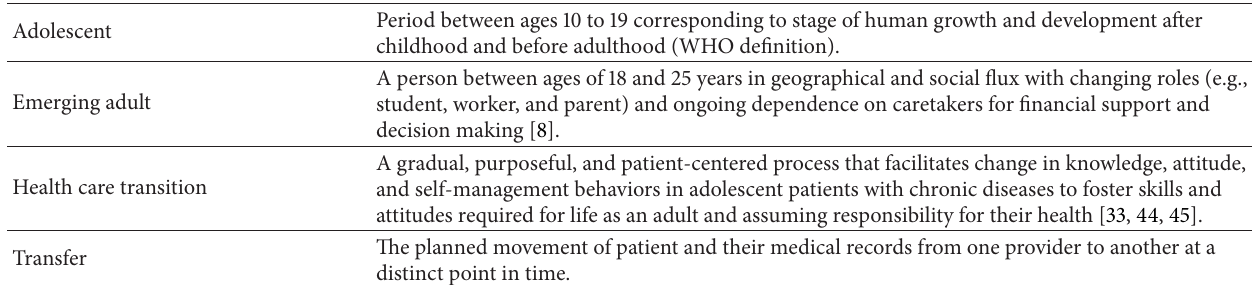
Table 1: Definitions of frequently used